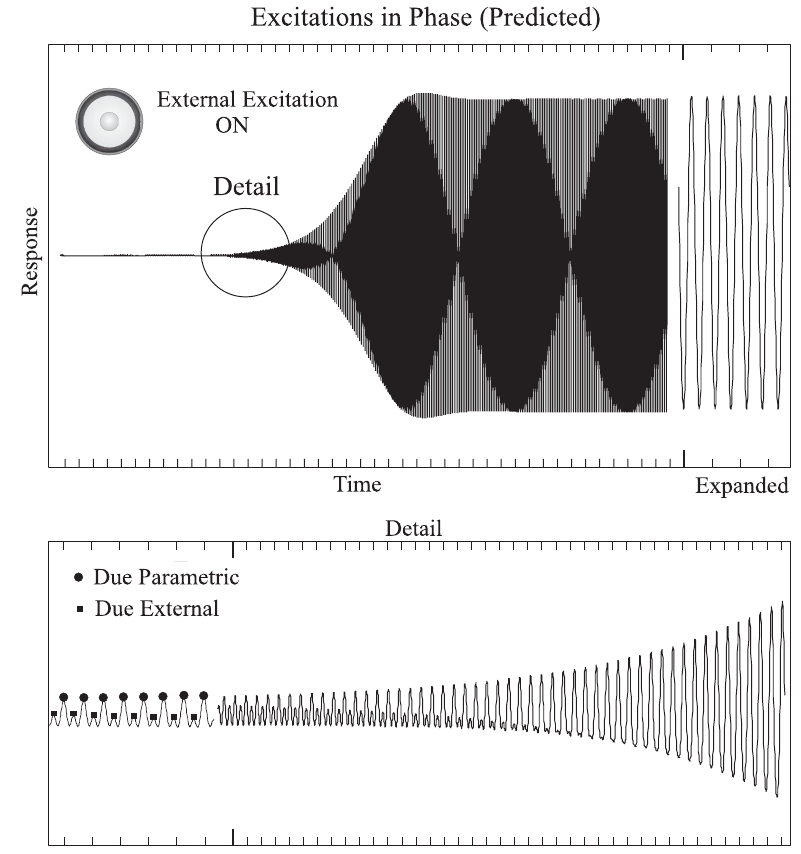
Fig. 15. Predicted time-history, with the effects of combined parametric and external excitations, both in